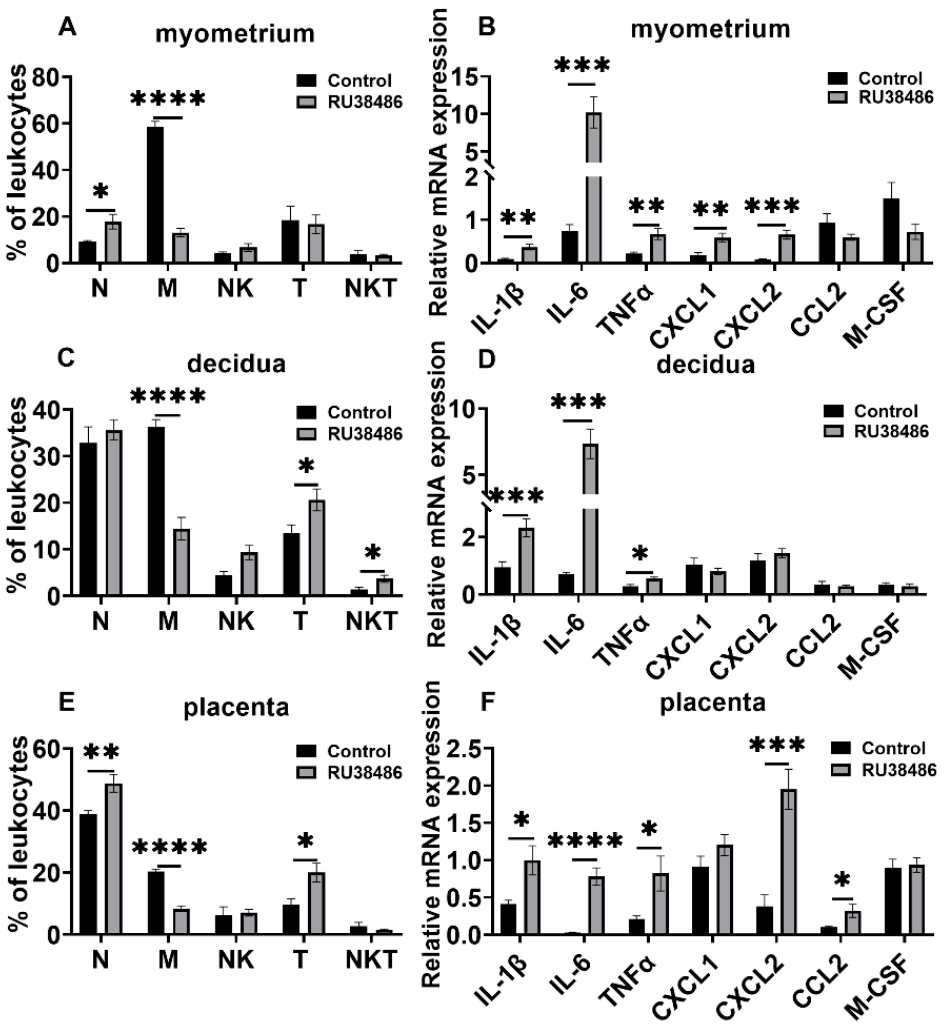
Figure 6. Changes in leukocyte subsets and cytokine and chemokine expression in gestational tissues at preterm labor induced by RU38486. Pregnant mice were administered RU38486 or vehicle at GD16. The mice with RU38486 were sacrificed after the onset of labor. The control mice were sacrificed at the corresponding time of the RU38486 group. Myometrium, decidua, and placenta were obtained for determination of leukocyte subsets and chemokine and cytokine expression. ( A , B ) Leukocyte subsets and cytokine and chemokine mRNA levels in myometrium; ( C , D ) leukocyte subsets and cytokine and chemokine mRNA levels in decidua; ( E , F ) leukocyte subsets and cytokine and chemokine mRNA levels in placenta. Data are expressed as mean ± SEM. n = 6 in each group. * p < 0.05, ** p <0.01, *** p < 0.001, **** p < 0.0001. N, neutrophils; M,